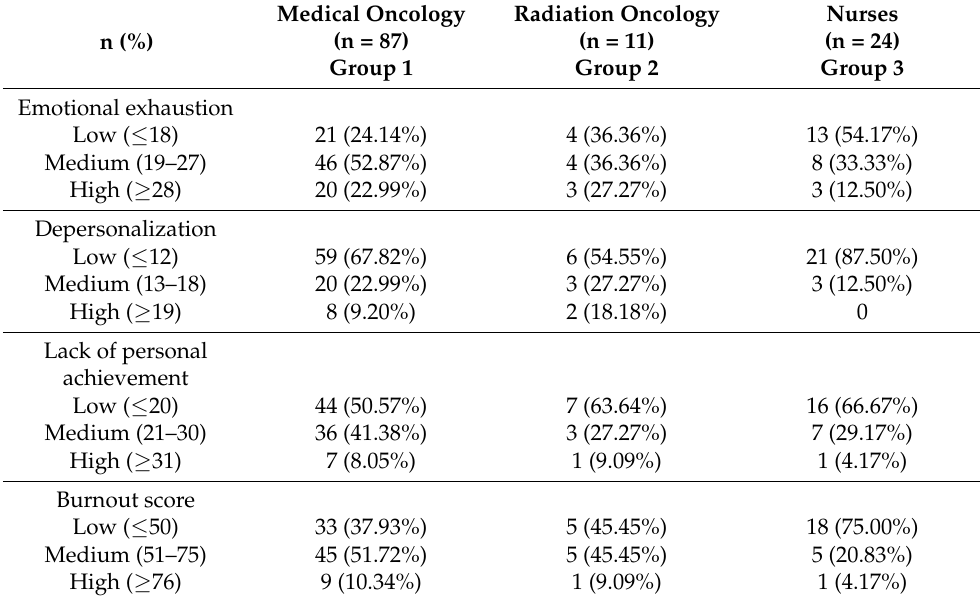
Table 2. Distribution of the sample for the burnout